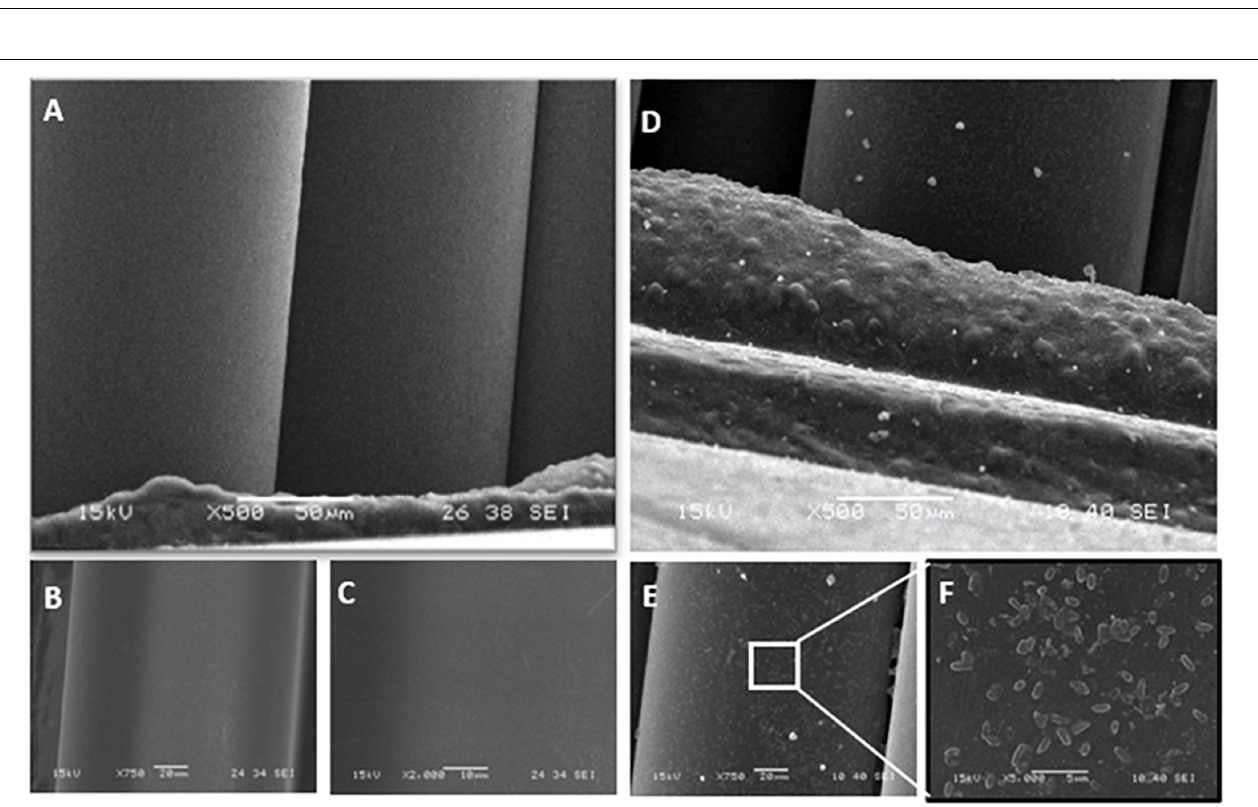
FIGURE 3 | Scanning electron micrographs of the clean sonic toothbrush head bristles at 500 × , 750 × , and 2,000 × magnification (A–C) and after biofilm sampling and suspending P. azotoformans PFl1A cells by vortex mixing and ultrasound, at 500 × (D) , 750 × (E) , and 5,000 × (F) .